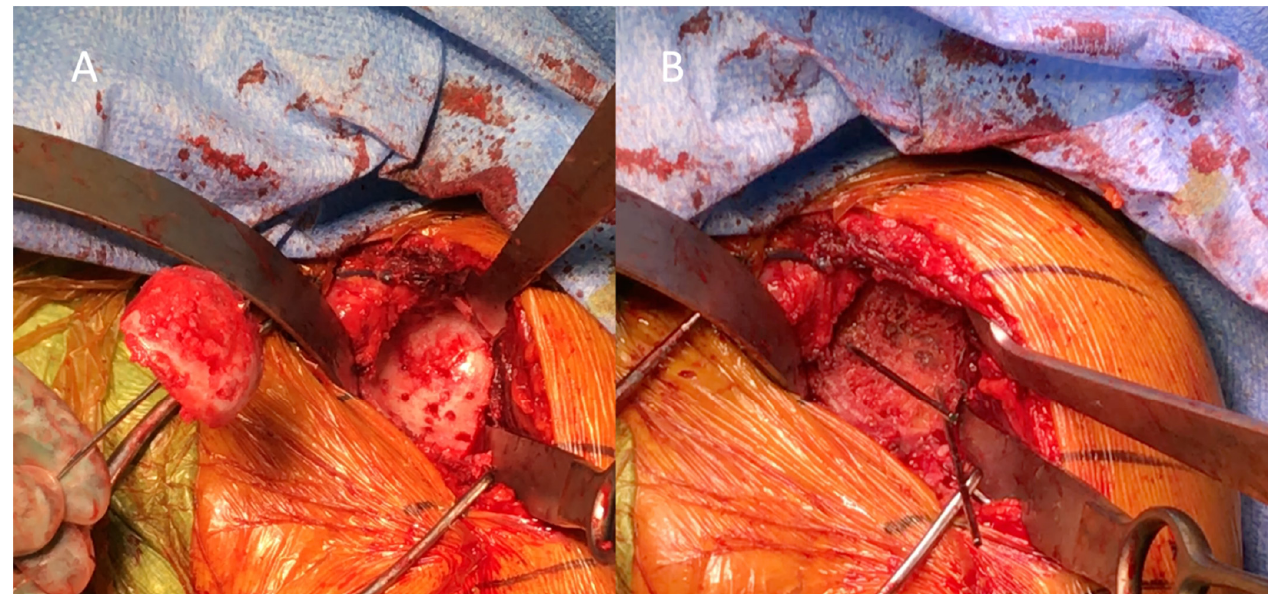
Figure 1. Sagittal view of a left glenoid with severe bone loss. ( A ) The glenoid is prepared with multiple small holes to promote bone healing and graft incorporation. ( B ) The graft is temporarily fixed to the native glenoid before screw insertion. In this case, bone graft alone is able to sufficiently restore the glenoid bone loss.